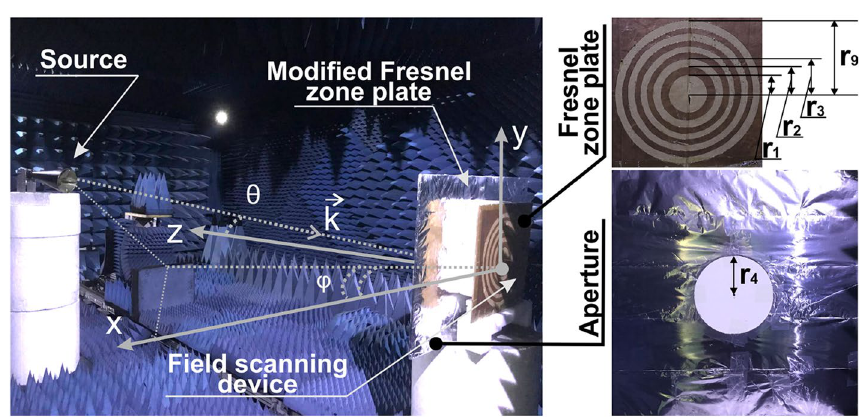
Figure 5. Photograph of the experimental setup—horn antenna transmits a wave that impinges the Fresnel lens-based DoA device. The loop probe scans the field at the Fourier plane of the lens. Samples are located on an RF-transparent white foam posts. Insets—photographs of the Fresnel zone plate and the